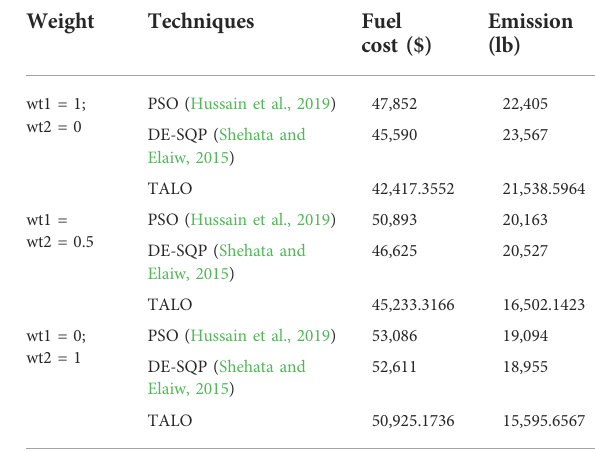
TABLE 6 5-Unit system comparison